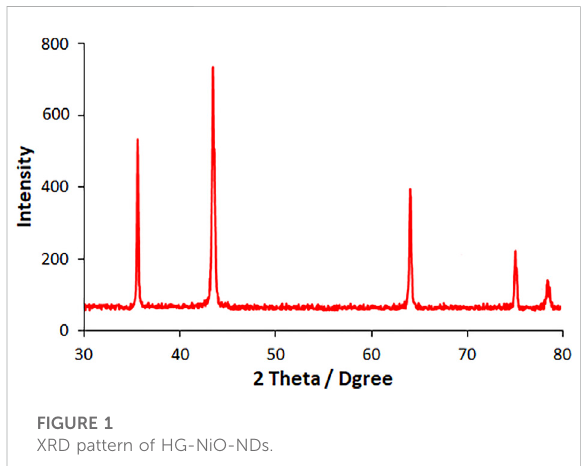
FIGURE 1 XRD pattern of